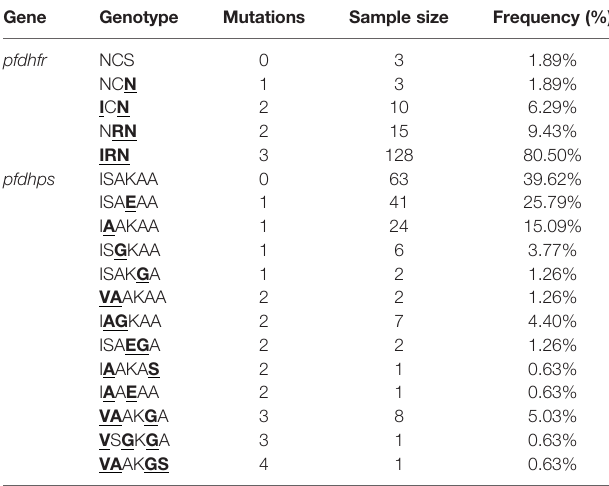
TABLE 2 | Prevalence of pfdhfr and pfdhps